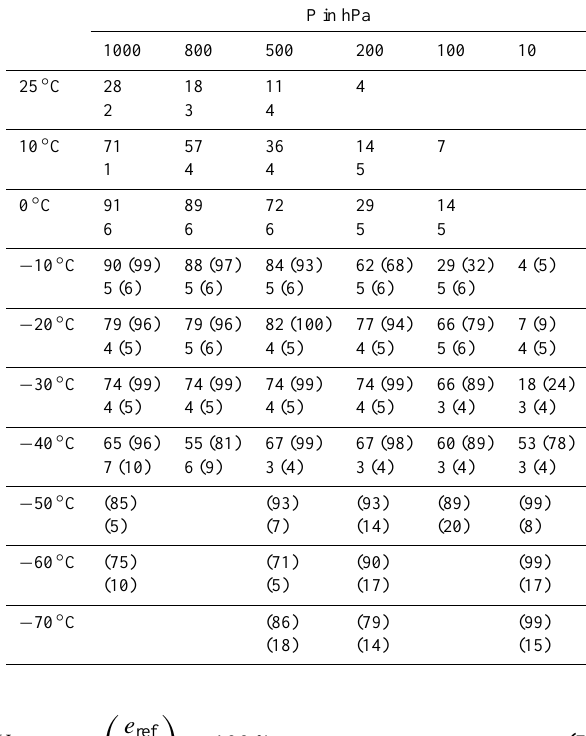
Table 2. Range of the relative humidity under investigation for the different temperature and pressure conditions. Relative humidity is calculated with respect to water U w or ice U i (marked by